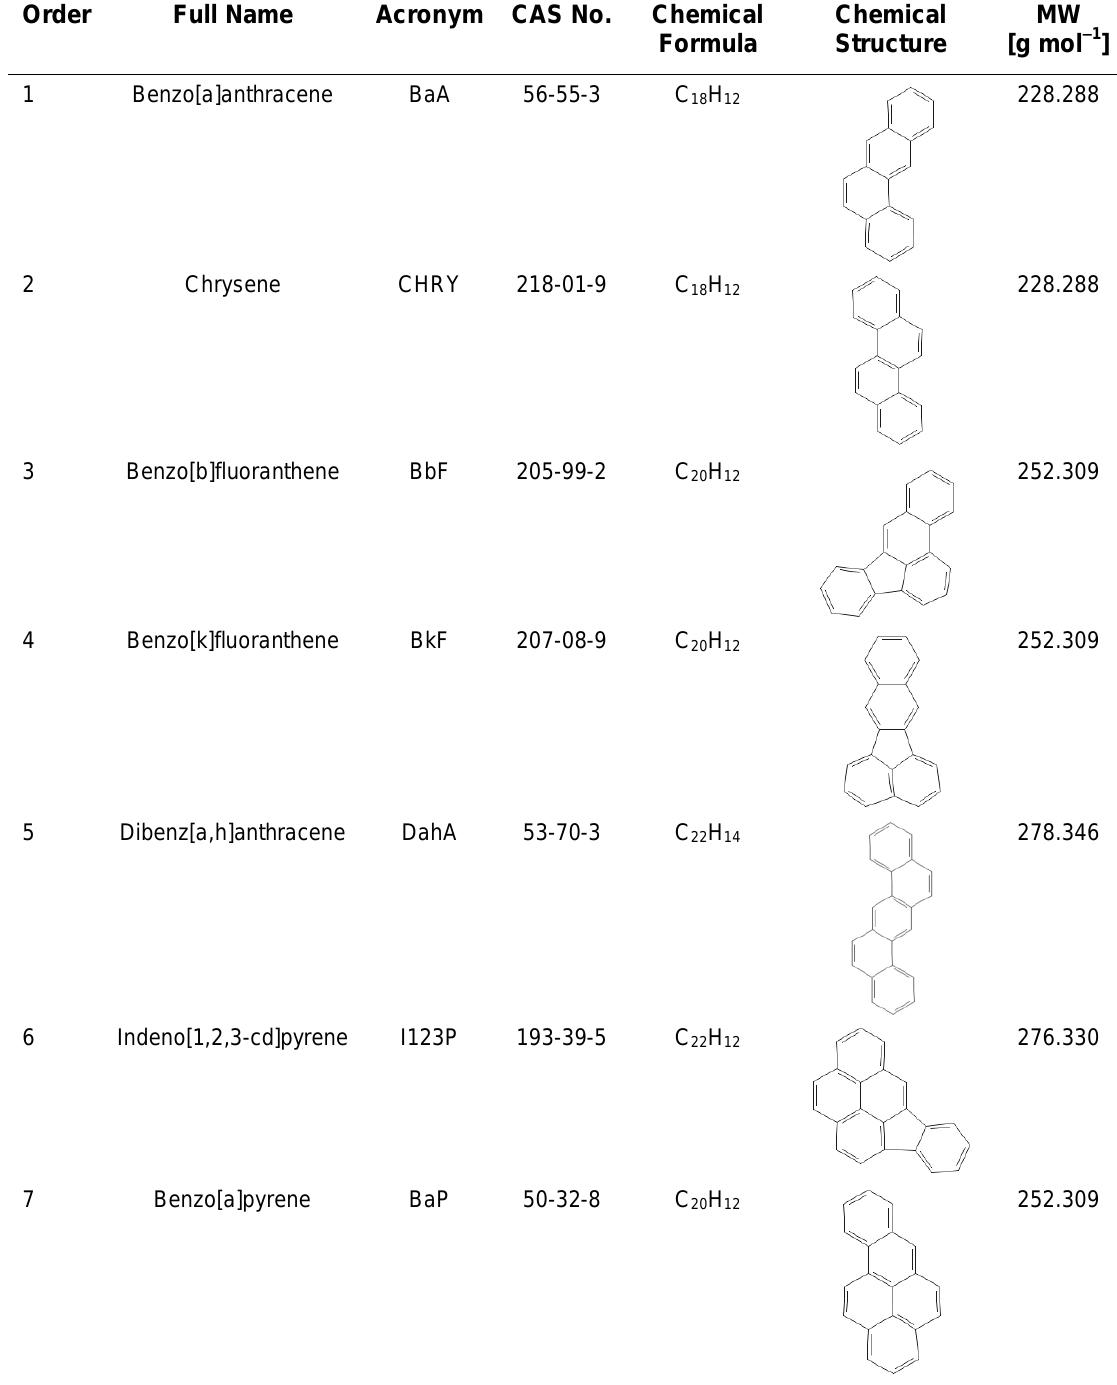
Basic Information for the Seven PAHs Measured in 15 Cities/Provinces in